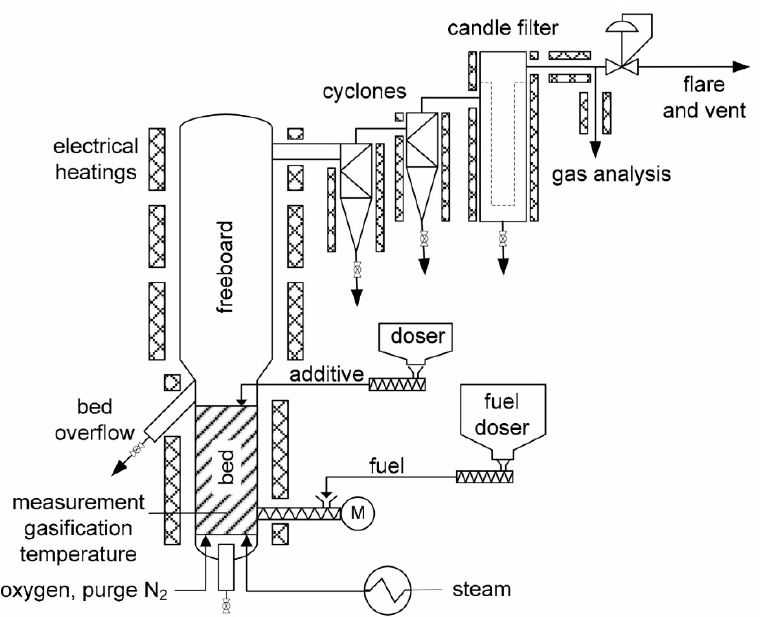
Figure 1. Schematic flow diagram of 20 kW fluidised bed gasification facility at the University of Stuttgart [2] .